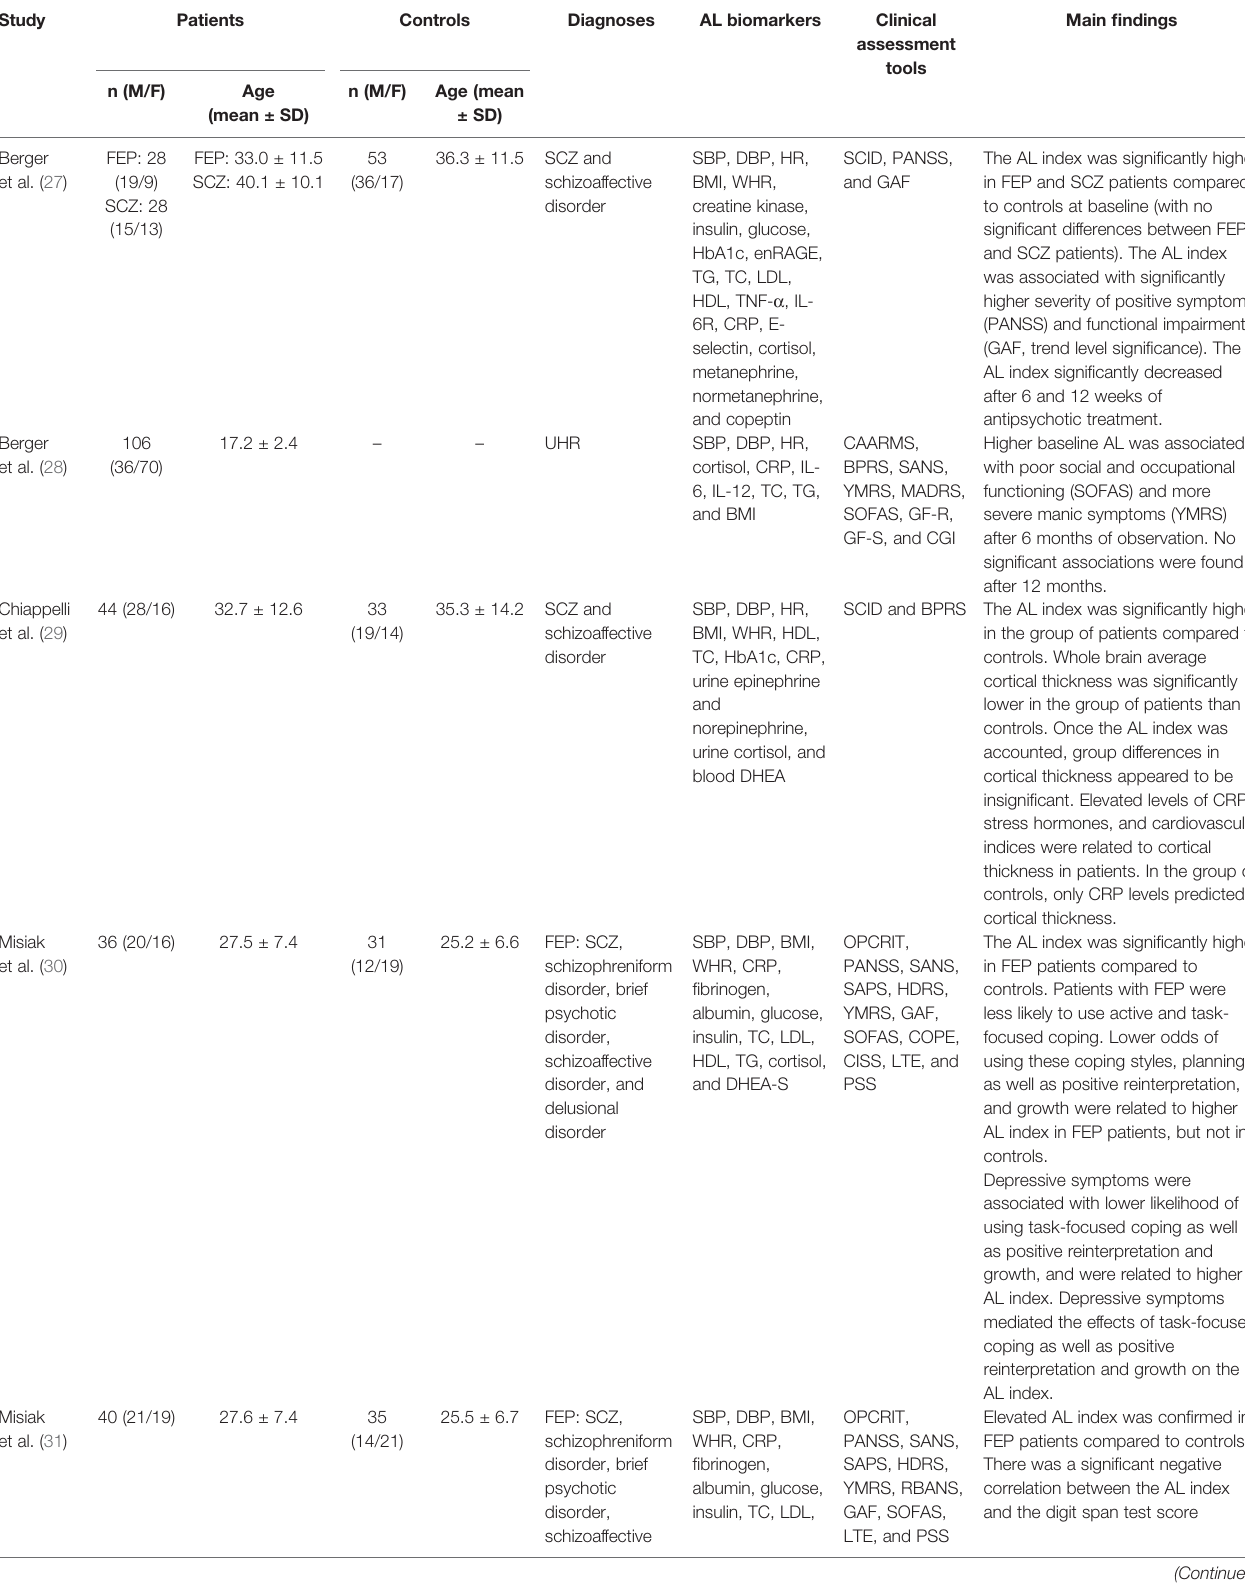
TABLE 1 | A summary of studies investigating the allostatic load index in psychosis.